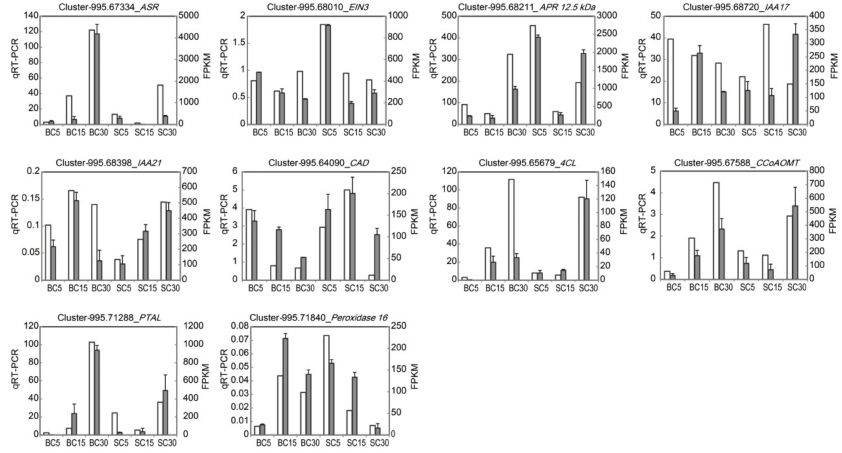
Figure 6. Expression of 10 selected genes as determined by qRT-PCR in comparison with the transcriptome results. The qRT-PCR values for each gene are the means ± SD of three biological replicates, with three technical replicates per experiment. The gene names and primers used for qRT-PCR analysis are shown in Table 1. The white bars indicate FPKM values as determined by transcriptome sequencing, and the grey bars show the expression as determined by qRT-PCR. ASR : abscisic acid stress ripening protein; EIN3 : ethylene-insensitive protein 3; APR 12 . 5 kDa : auxin-repressed 12.5 kDa protein-like; IAA17 : auxin-responsive protein IAA17-like; IAA21 : auxin-responsive protein IAA21; CAD : cinnamyl–alcohol dehydrogenase; 4CL : 4-coumarate–CoA ligase; CCoAOMT : caffeoyl–CoA O -methyltransferase; PTAL : phenylalanine/tyrosine